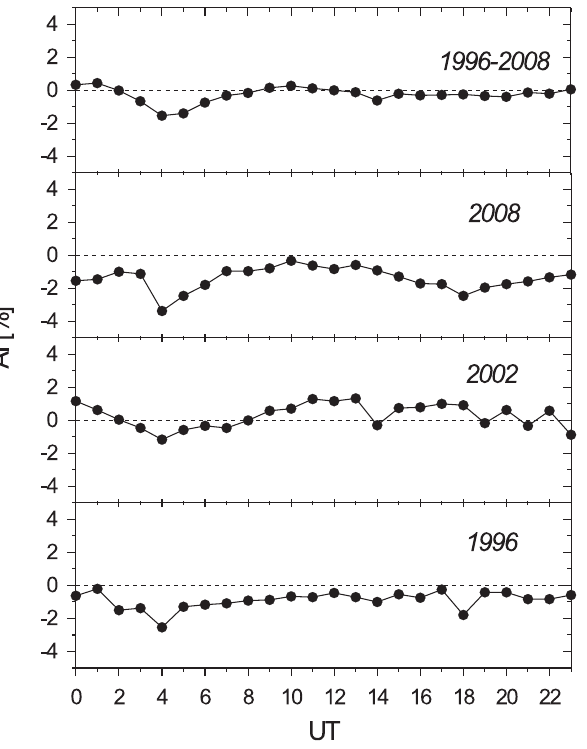
Fig. 6. Diurnal variations of mean AI values for different years (1996, 2002, and 2008) and for the full interval between 1996 and 2008.